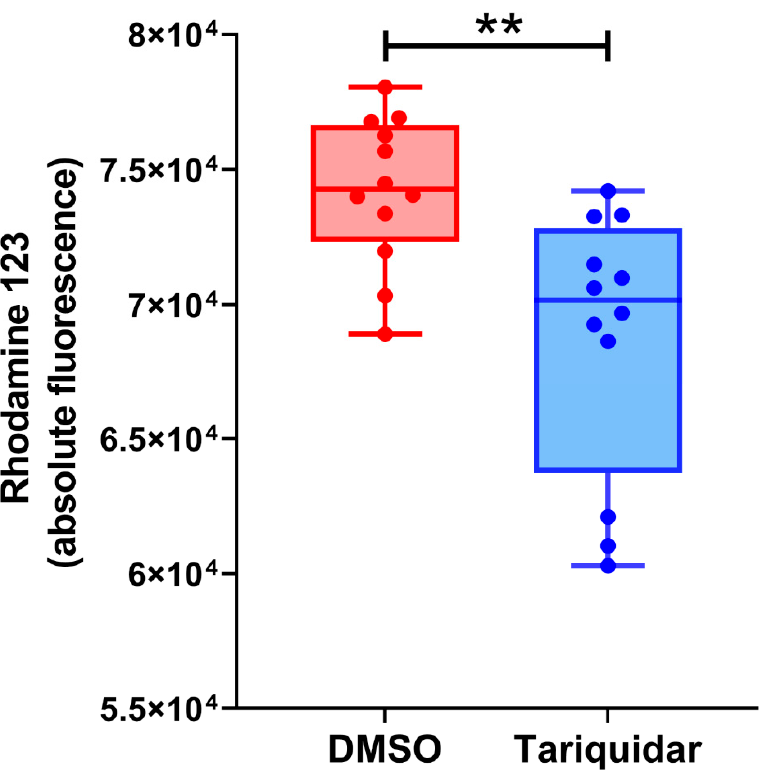
Figure 3. Uptake (or accumulation) of the Pgp substrate rhodamine 123 in the crude endolysosomal fraction of rat liver in the absence or presence of the Pgp inhibitor tariquidar. Tariquidar was used at a concentration of 0.5 µM and rhodamine 123 at 2 µM. Data are shown as boxplots with whiskers from minimum to maximal values; the horizontal line in the boxes represents the median value. In addition, individual data are shown. The experiment was performed 4-times with three replicates per experiment. The significance of the difference is indicated by asterisks (** p = 0.0018).